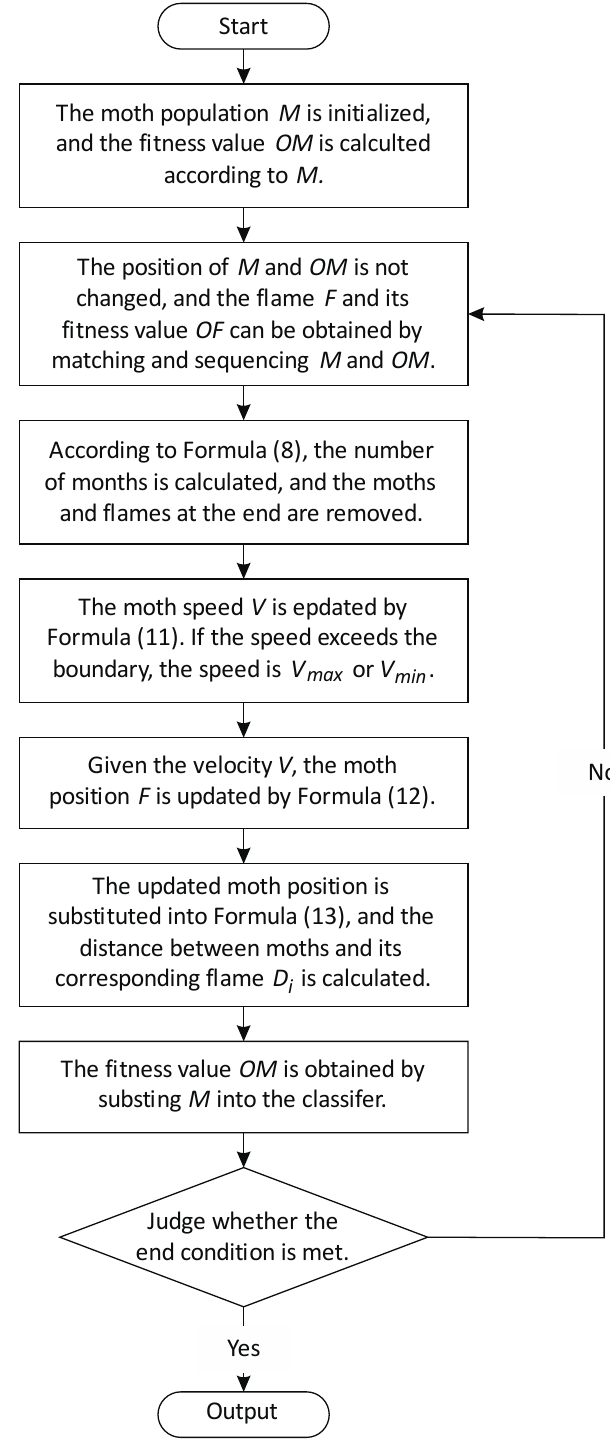
Figure 1. Flow chart of the proposed integrated optimization algorithm.